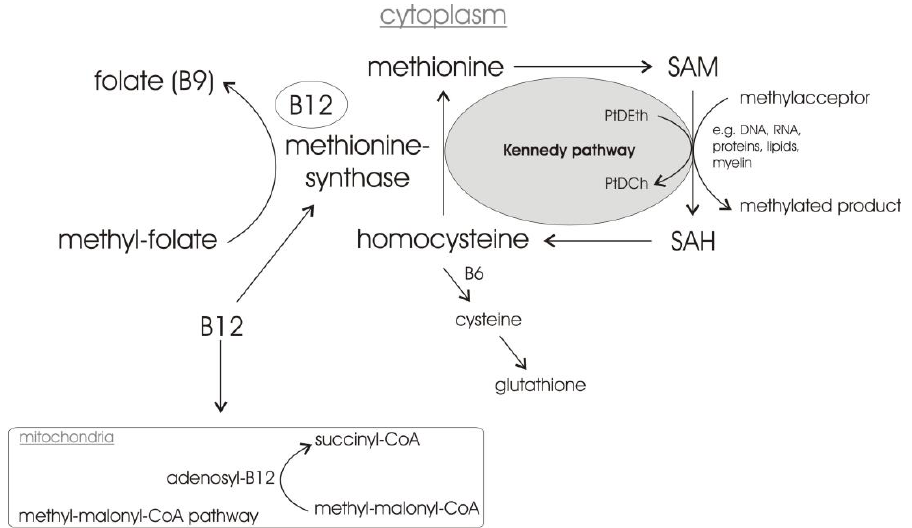
Figure 2. Stylized illustration of the homocysteine/methionine cycle and biochemical mechanism of action of vitamin B12 in the homocysteine/methionine and the methyl-malonyl-CoA pathway. The complex Kennedy pathway involved in phosphatidylcholine synthesis is not illustrated in